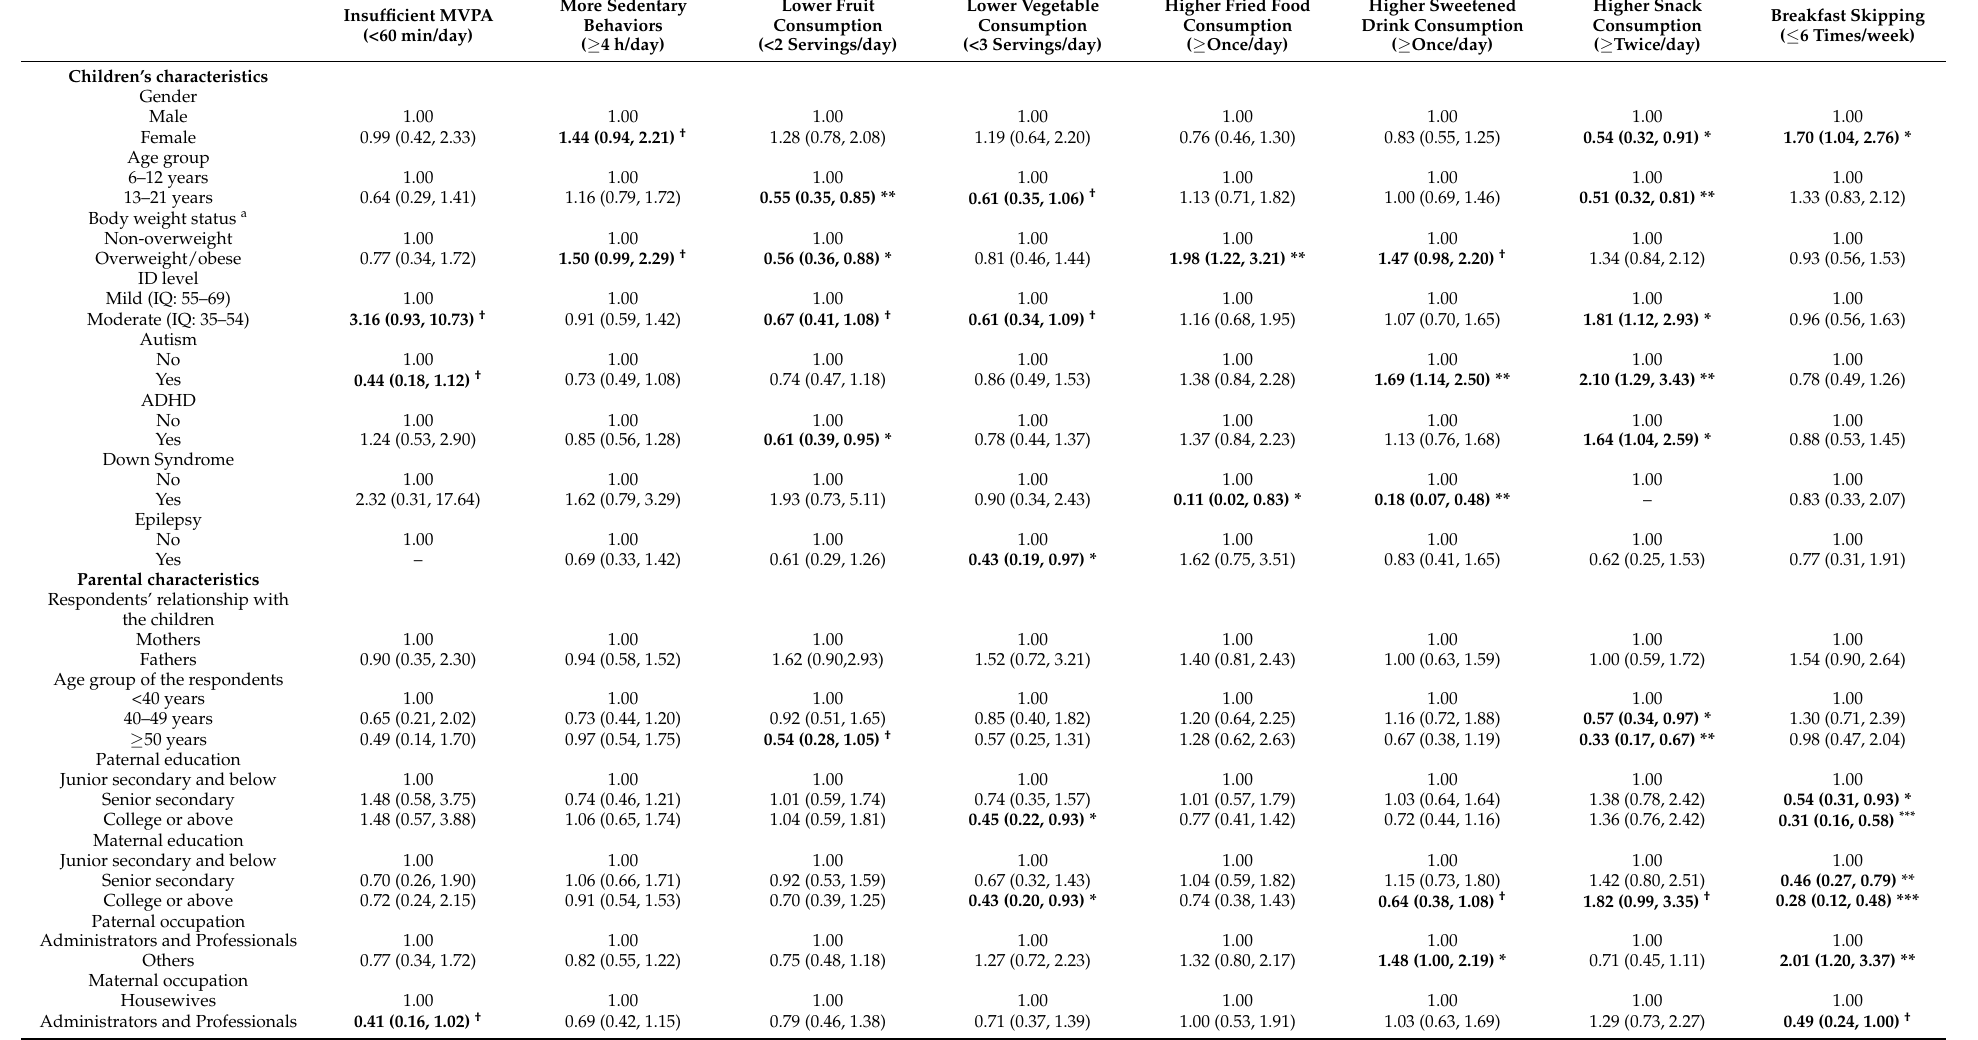
Table 3. Associations between background characteristics and children’s unhealthy behaviors (CORs, 95%